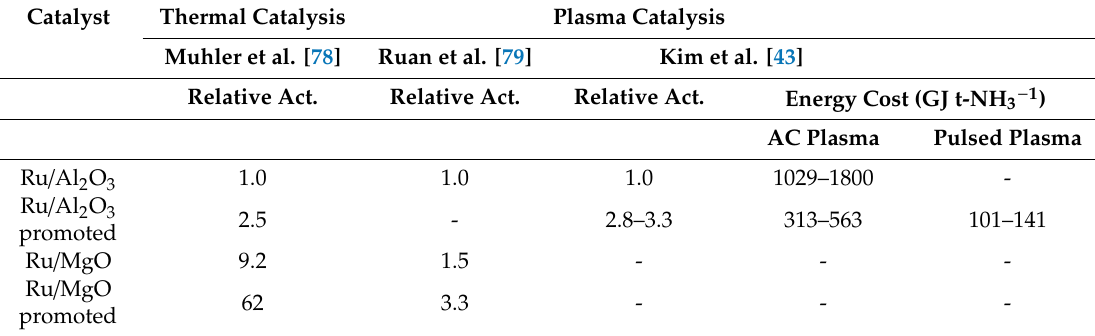
Table 1. Comparison of activity trends over Ru catalysts for thermal catalysis and for plasma catalysis. Thermal catalysis: data of Muhler et al. [78], 385 ◦ C, 1 atm, 40 mL min − 1 , H 2 :N 2 = 3:1, 138 mg catalyst. Plasma catalysis: data of Ruan et al. [79], 180 ◦ C, 60 mL min − 1 , H 2 :N 2 = 3:1, 1.1-3.7 mol. % NH 3